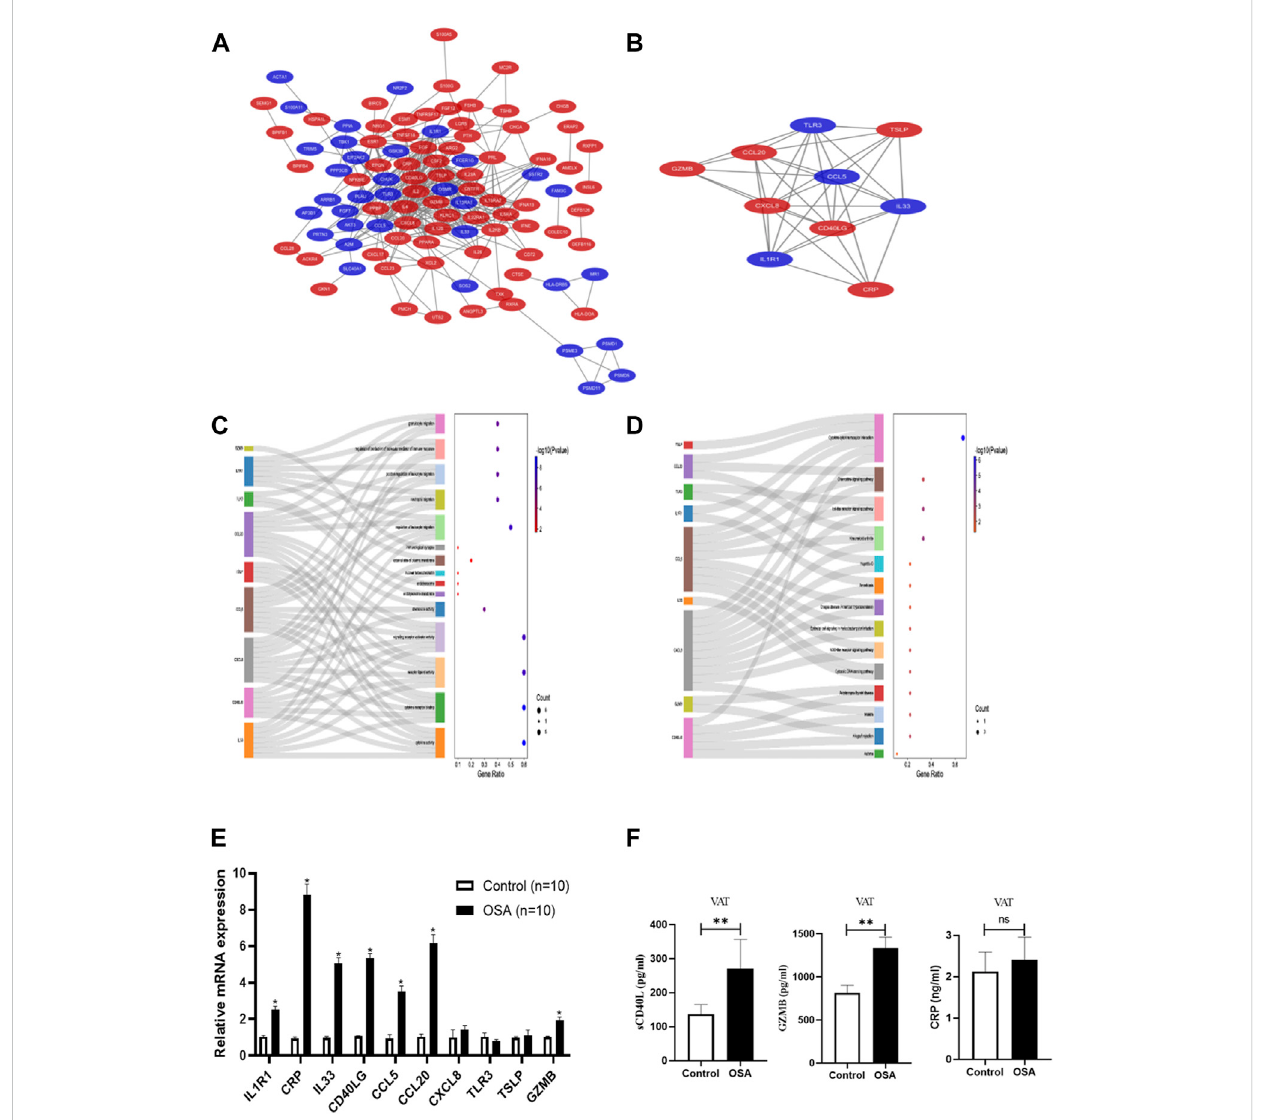
FIGURE 2 Protein-protein interaction (PPI) network construction, hub gene identi fi cation and functional enrichment analysis. (A) The PPI network based on STRING database and Cytoscape software, red color represents upregulated genes and blue color represent downregulated genes. (B) Hub genes identi fi ed by Cytoscape MCODE plug-in, red color represents upregulated genes and blue color represent downregulated genes. (C) Sankey dot of GO enrichmentanalysesofhubgenes. (D) Sankey dotofKEGGpathway enrichmentanalysesofhubgenes.Thedot plotshowed thehub genesspeci fi c to GO terms or KEGG pathways and the total number of genes in each enriched pathway. External validation of the hub genes at mRNA level (E) and protein level (F)